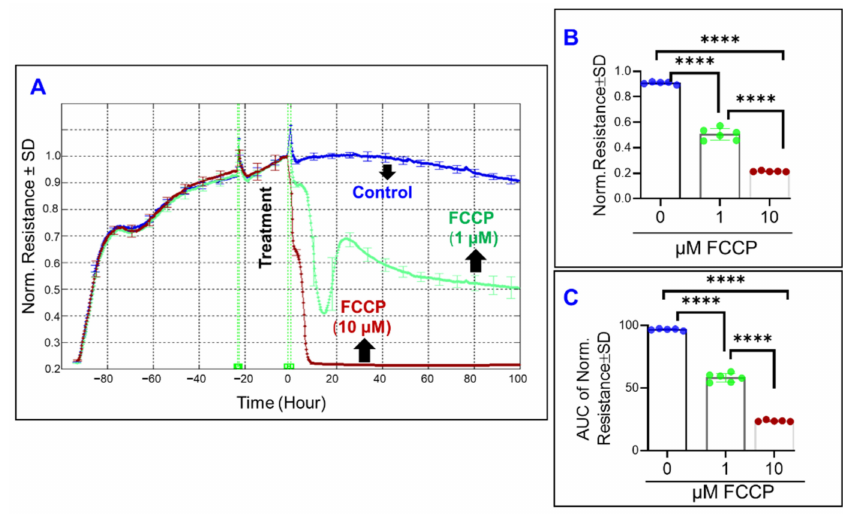
Figure 5. Real-time measurement of the total resistance across the ARPE-19 cells in a state of OxPhos uncoupling. ( A ) Plot of normalized resistance vs. time for the cell groups of the control, FCCP 1 µ M, and FCCP 10 µ M. Resistance was measured from the time the cells were placed on the ECIS electrode to the time 100 h after treatment application. Resistance was normalized to T = 0, the time of treatment application. ( B ) Bar chart representation of each group’s normalized resistance at the endpoint of the experiment, T = 100 h. Comparison between all three groups displays a significant difference. ( C ) Bar chart representation of the areas under the normalized resistance curve for the interval T = 0–100 h. Using AUC, all three groups demonstrate a significant difference from each other. Abbreviations: AUC, area under the curve. Data shown are the mean ± SD of 5–6 independent biological replicates per group. p values are **** p ≤ 0.0001.